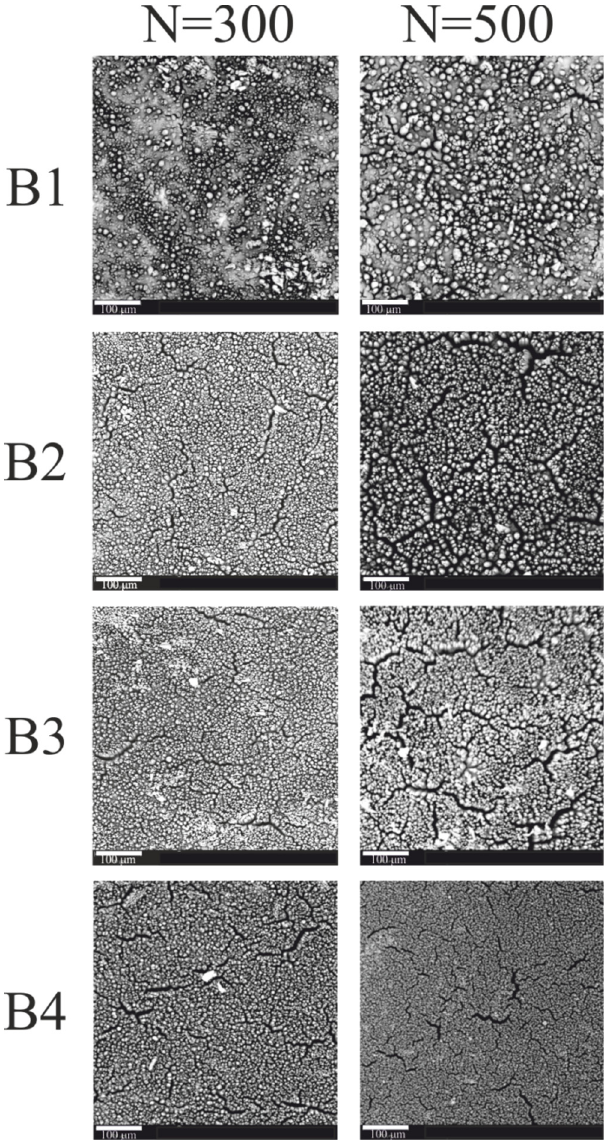
Figure 4. SEM images of B1–B4coatings(scale—100 μ m).